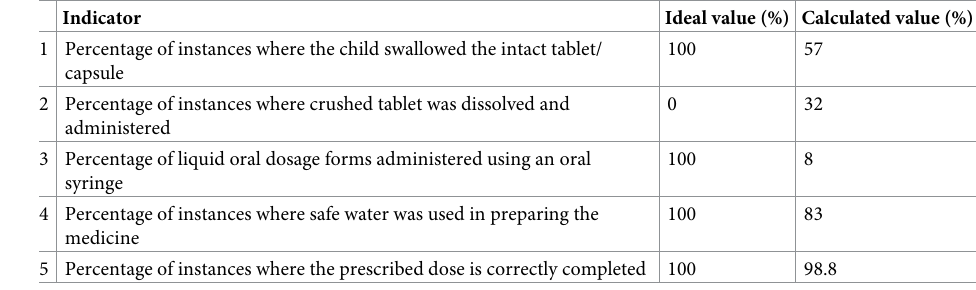
Table 2. Summary of the indicator